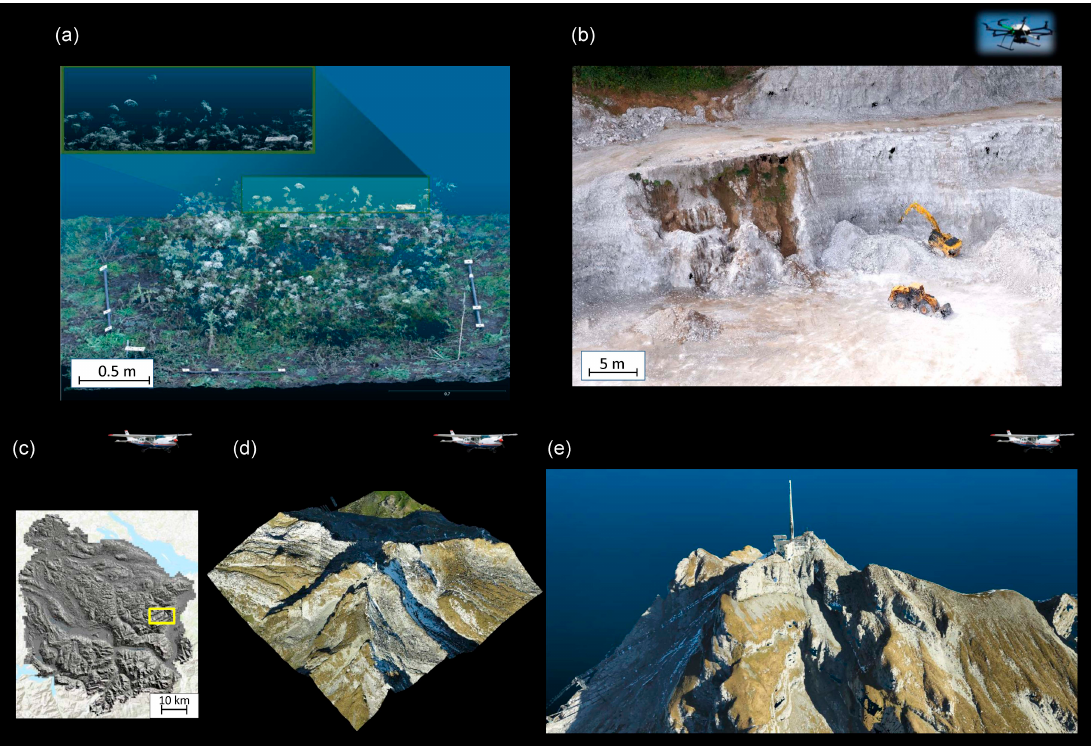
Figure 3. Three-dimensional (3D) representations derived from overlapping images: ( a ) Representations of 3D plant species structure “Onobrychis viciifolia” and “Daucus carot” created with Structure from Motion (SfM) techniques as well as the use of a Time of Flight (TOF) 3D camera, a laser light sheet triangulation system and a coded light projection system (from Kröhnert et al., [85]), ( b ) Structure from Motion (SfM) techniques based dense point cloud that shows a gypsum mine close to Nordhausen, Germany. In total 250 RGB (red-green-blue) pictures, average point density 1020 points/m 2 , UAV, ( c – e ) Digital Surface Model (DSM)—Santis Sankt Gallen, Switzerland, Aerial Laser Scanner (ALS)—LiDAR (RIEGL), point density (15 points/m 2 ), total 51 million points, airplane.